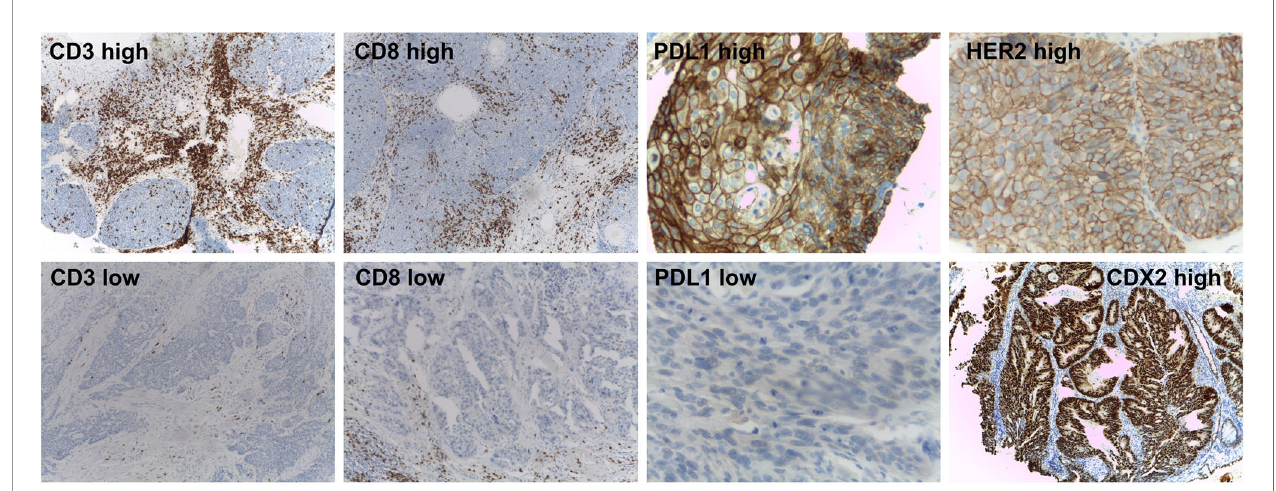
FIGURE 2 | Immunohistochemical markers assessed in the non-metastatic rectal cancer cohort. Representative immunohistochemistry results for high and low CD3 and CD8 TILs, PD-L1 expression (up and down panels respectively), high HER2 and CDX2-expressing